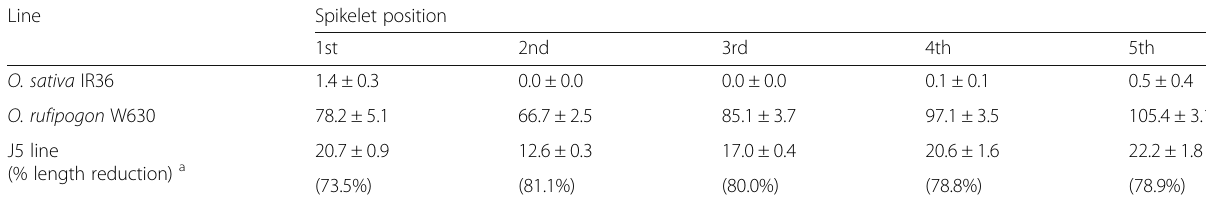
Table 1 Mean awn lengths (mm) and standard deviation observed for the parental lines, O. sativa IR36, O. rufipogon W630 and the J5 line ( n = 5)